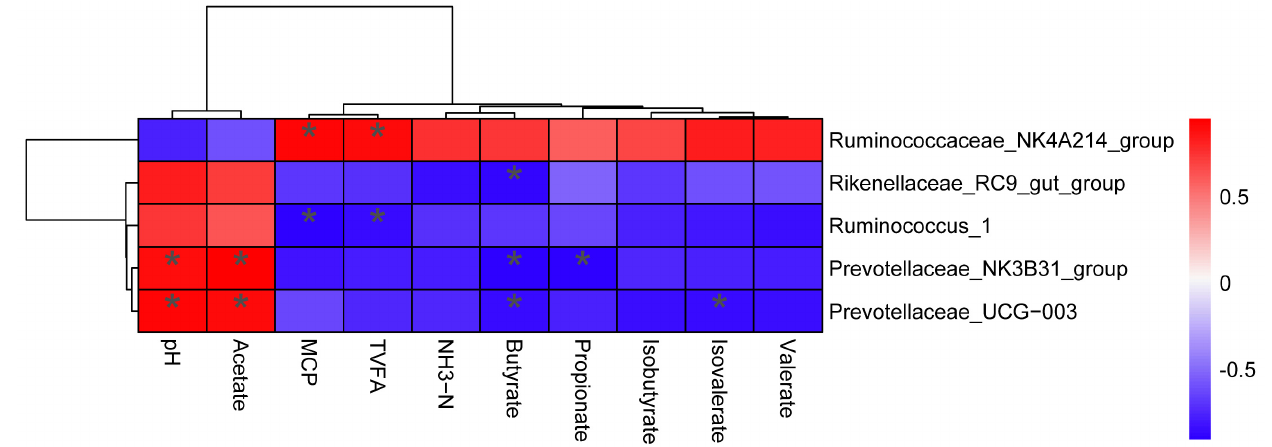
Figure 3. Spearman correlation between the rumen fermentation parameters and predominant genera. * indicates a significant level of 0.05.